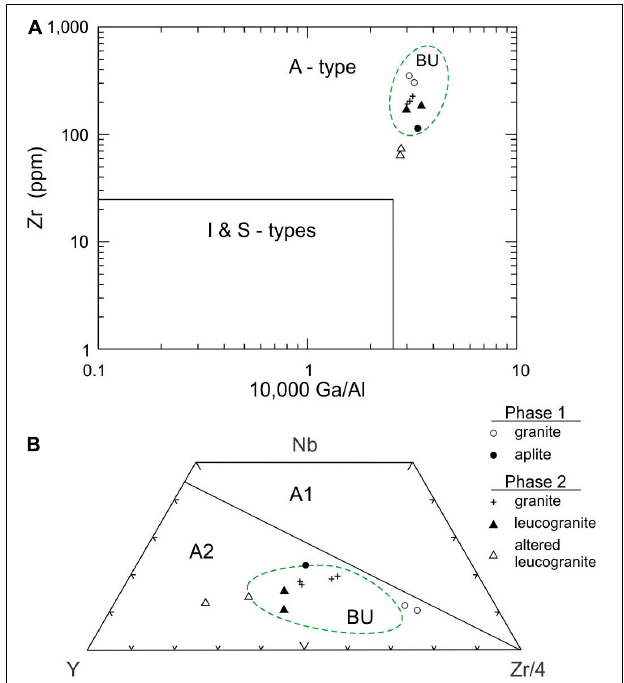
FIGURE 11 | (A) Plot of 10 4 Ga/Al versus Zr (ppm) of Whalen et al. (1987) showing the A-type characteristics of the granitic rocks of the Tukham pluton. I and S field is for I- and S-type granites. (B) Y-Nb-Zr/4 diagram of Eby (1992) for the granitic rocks of the Tukham pluton showing the fields of the A1 and A2 granitoids. The dashed green curves show the fields (BU) for the Bayan-Ulan